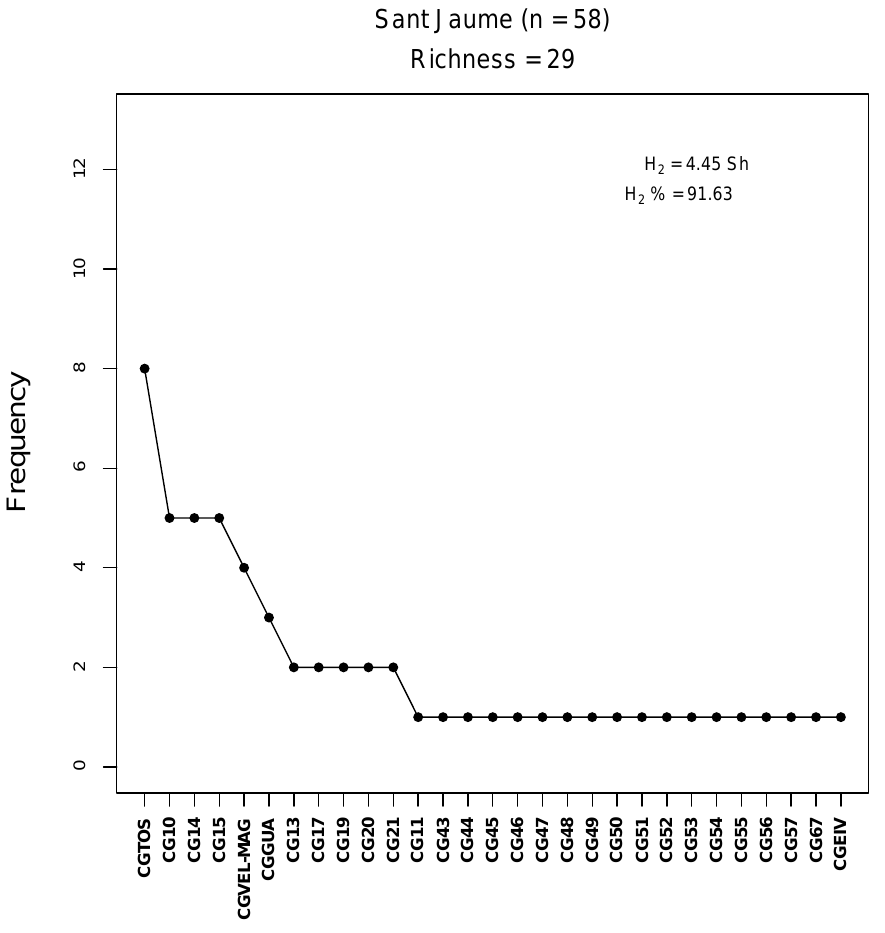
Figure 10. Rank abundance graph of the 29 defined groups based on the 58 studied individuals. H 2 : information entropy (in Shanons, Sh); H 2 %: percentage of the maximum possible attainable.